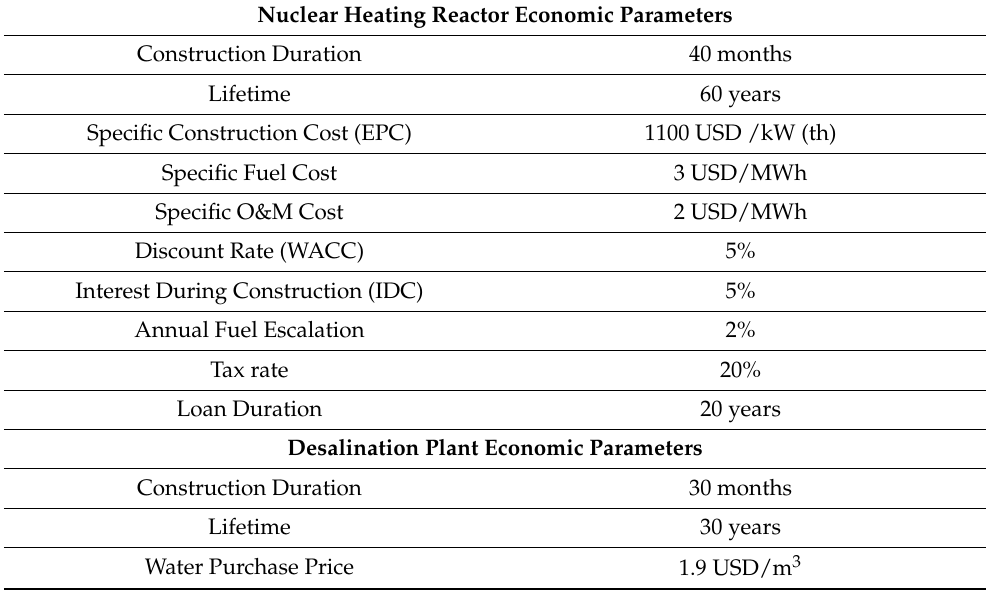
Figure 5. Simplified schematic diagram of suggested NHR170 coupled with the MED-TVC. Table 8. Economic parameters for the nuclear reactor NHR170 and the desalination plant.